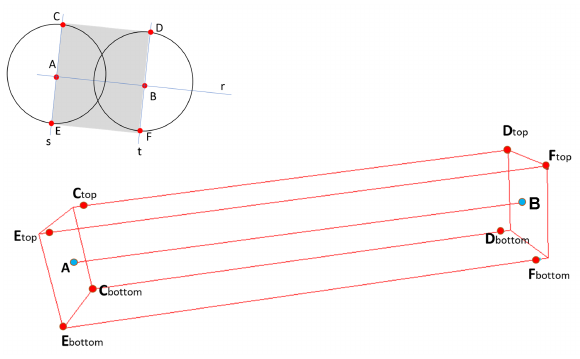
Figure 2. ROI generation trough an oriented Bounding